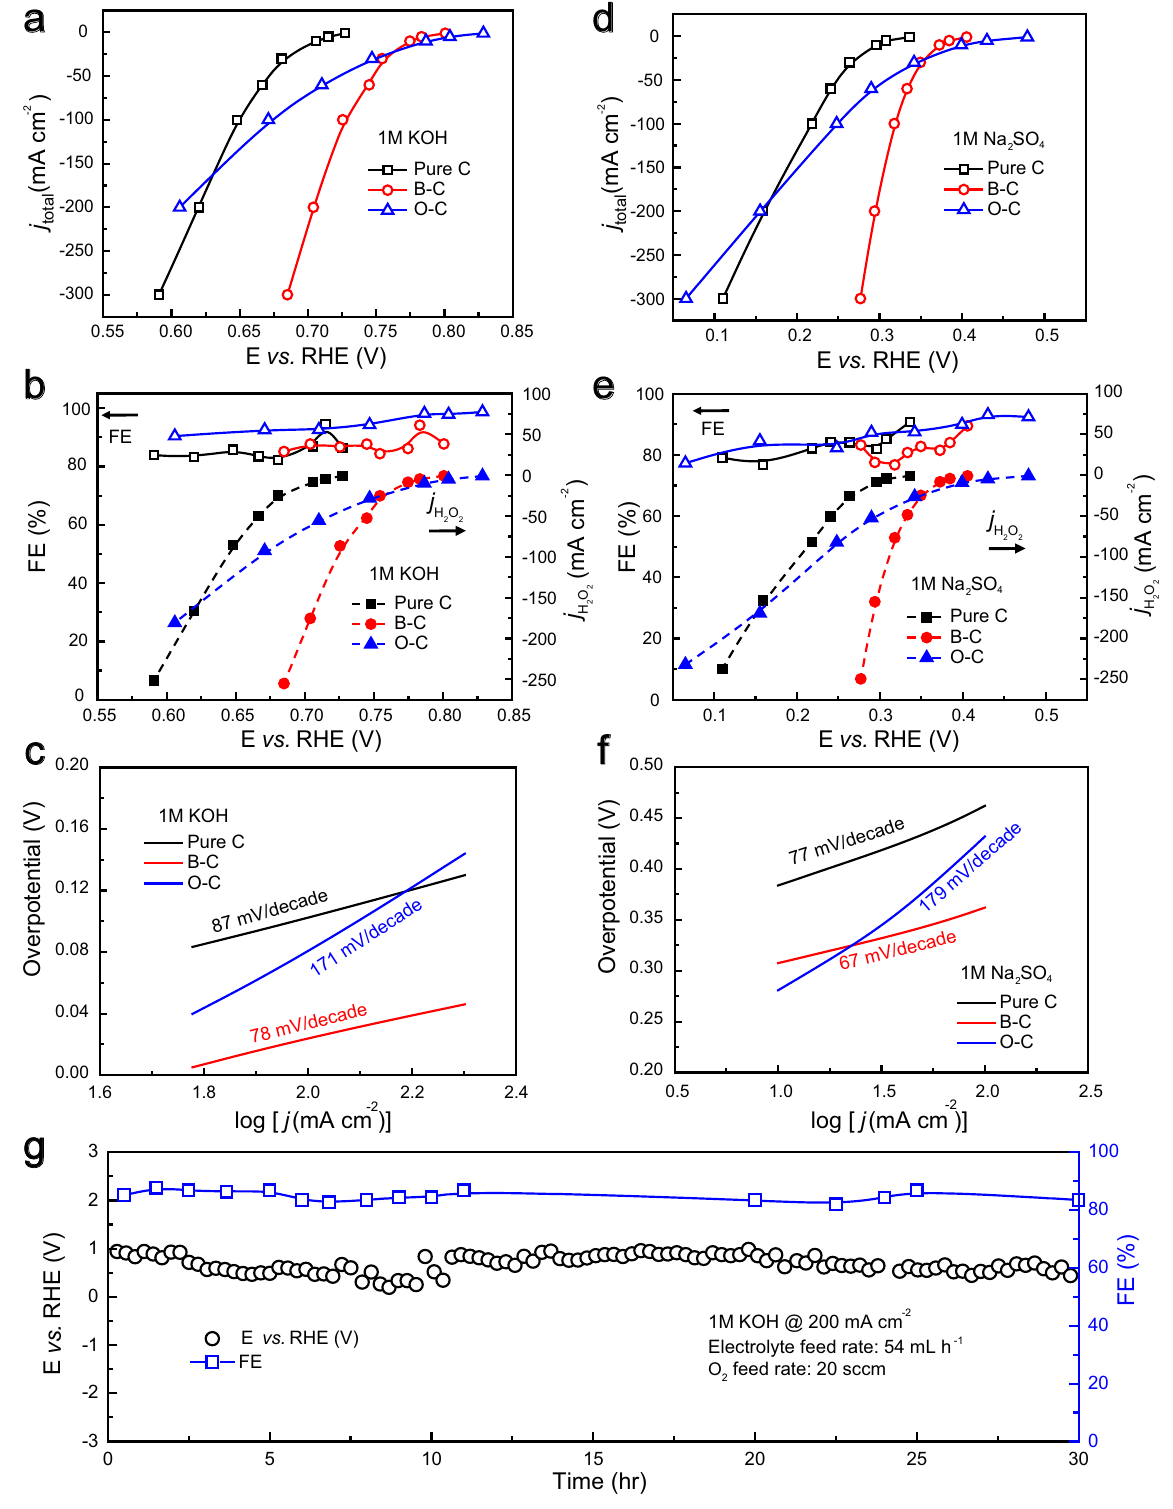
Fig. 5 Three-electrode fl ow-cell performance of catalysts. I – V curve for Pure C, B – C and O – C in ( a ) 1M KOH and ( d ) 1M Na 2 SO 4 . Faradaic ef fi ciency and H 2 O 2 partial currents measured are shown in ( b ) 1 M KOH and ( e ) 1 M Na 2 SO 4 . Note that all the I – V curves and faradaic ef fi ciency were taken average of 2 – 3 independent tests for each of the samples. Corresponding Tafel plots for three catalysts in ( c ) 1M KOH and ( f ) 1M Na 2 SO 4 . The thermodynamic equilibrium potentials are taken as 0.75 V vs. RHE in 1M KOH and 0.68 V vs. RHE in 1M Na 2 SO 4 19 . g Stability test of our B – C catalyst under 200 mA cm − 2 in 1 M KOH. The electrolyte feeding rate was fi xed at 54 mL h − 1 , and the oxygen feeding rate was fi xed at 20 sccm. All the I – V curves are manually iR - compensated. (see